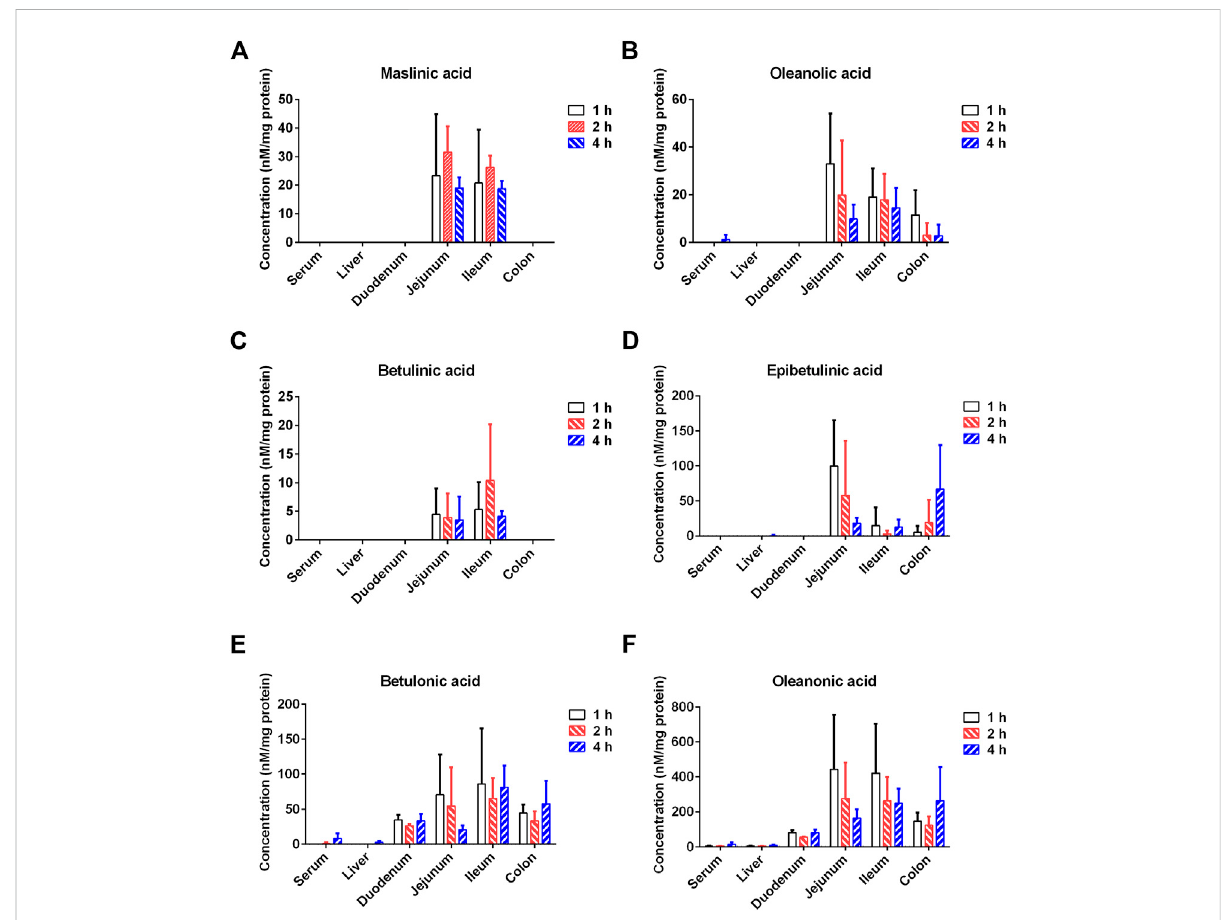
FIGURE 7 Tissuedistributionofthemajor constituentsofStyrax(maslinicacid (A) ,oleanolicacid (B) ,betulinicacid (C) ,epibetulinicacid (D) ,betulonicacid (E) , and oleanonic acid (F) ) after a single oral dose of Styrax (100 mg/kg) to